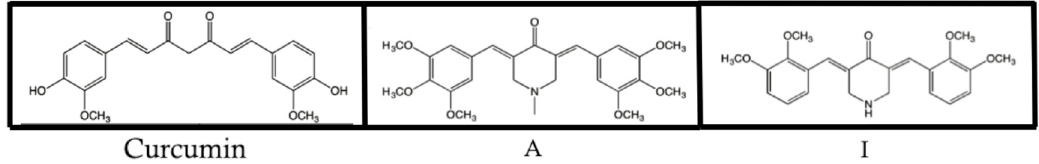
Figure 1. Structures of curcumin and analogs A and I. Previously published in Pignanelli et al. [24]. 133